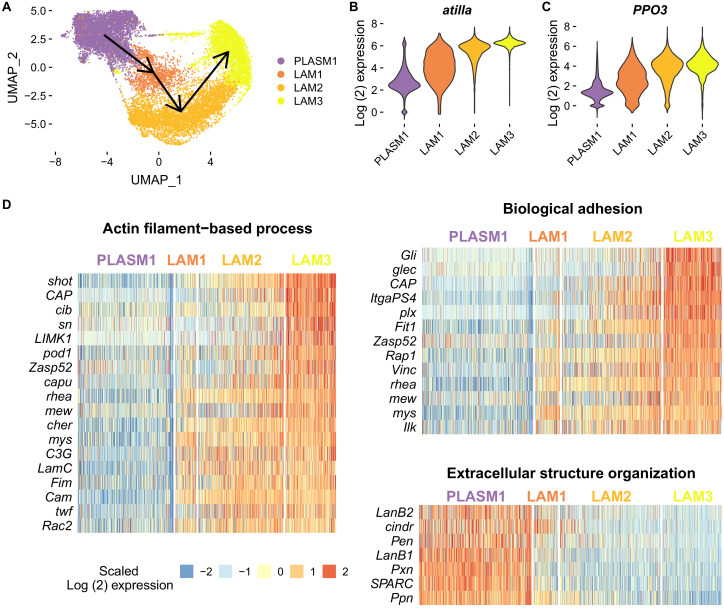
Changes in cell state following infection and adaptation to high rates of parasitism.(A) Trajectory of lamellocyte differentiation. Plasmatocyte progenitors and lamellocytes were subclustered, the trajectories inferred from multi-dimensional principle components analysis, and the lineage projected onto the two-dimensional UMAP plot. (B–C) Log2 expression levels of atilla and PPO3. Relative expression levels were estimated from normalized and scaled unique molecular identifier counts. (D) Heatmaps of genes that are upregulated in either the starting or terminal clusters of lamellocyte differentiation and belonging to significantly enriched gene ontology categories (biological function). Log2 fold change gene expression levels were centred on their mean value and divided by their standard deviation.Figure 4—source data 1.Changes in cell state following infection and adaptation to high rates of parasitism.